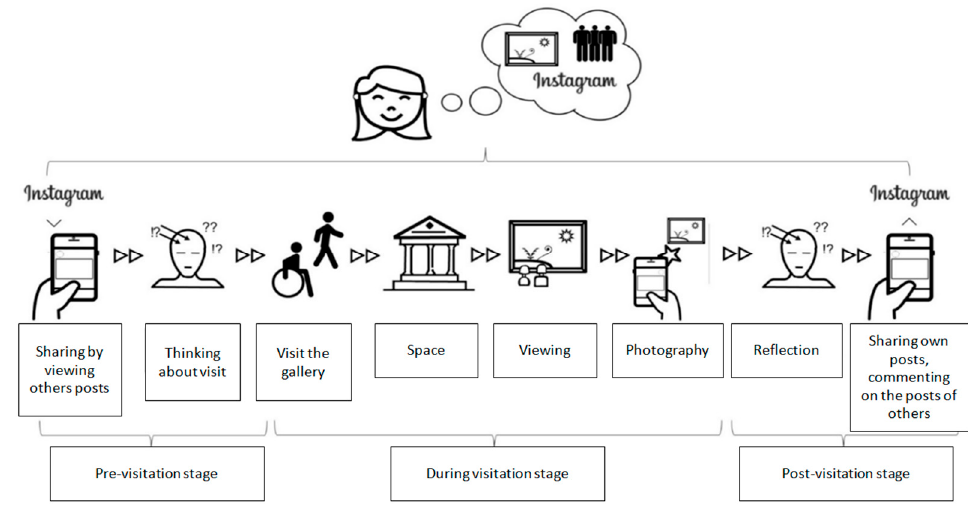
Figure 1. Art Gallery Visitor Instagramming [38].